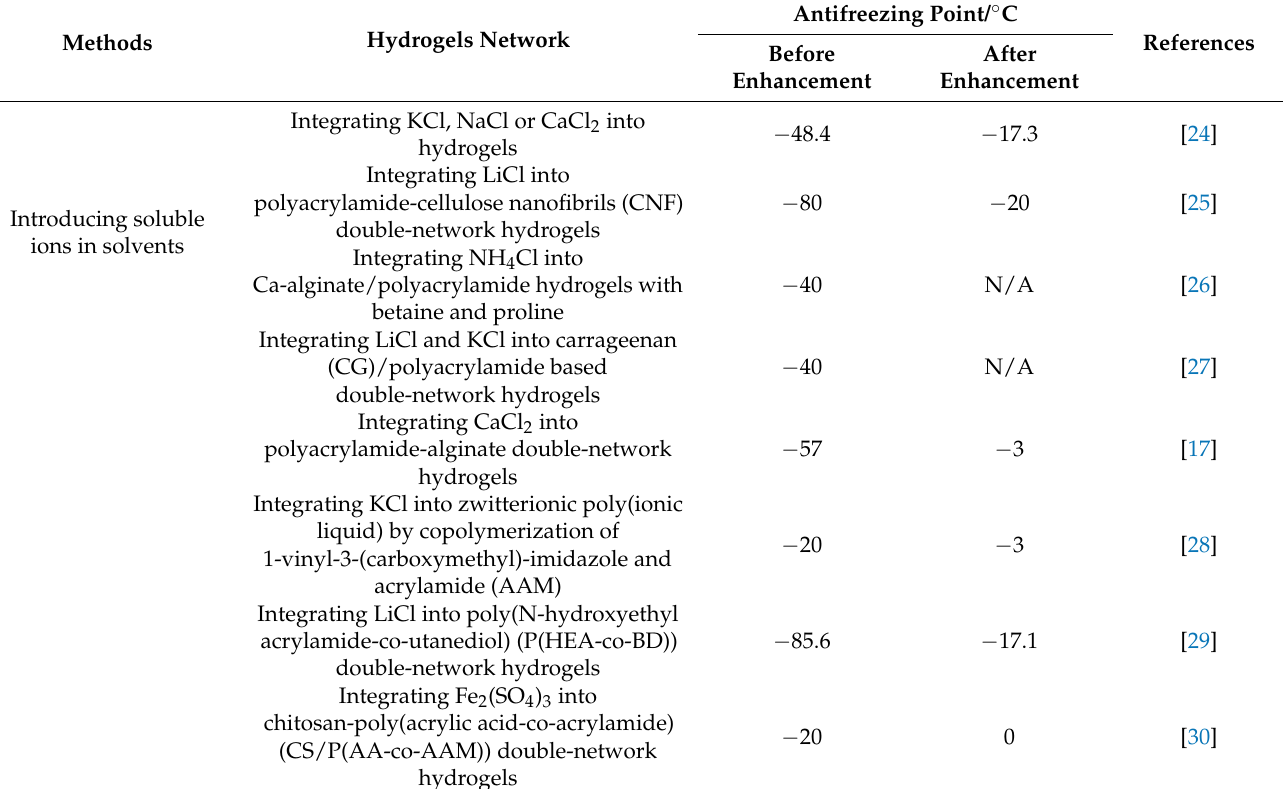
Table 1. General methods to enhance the anti-freezing properties of hydrogels.